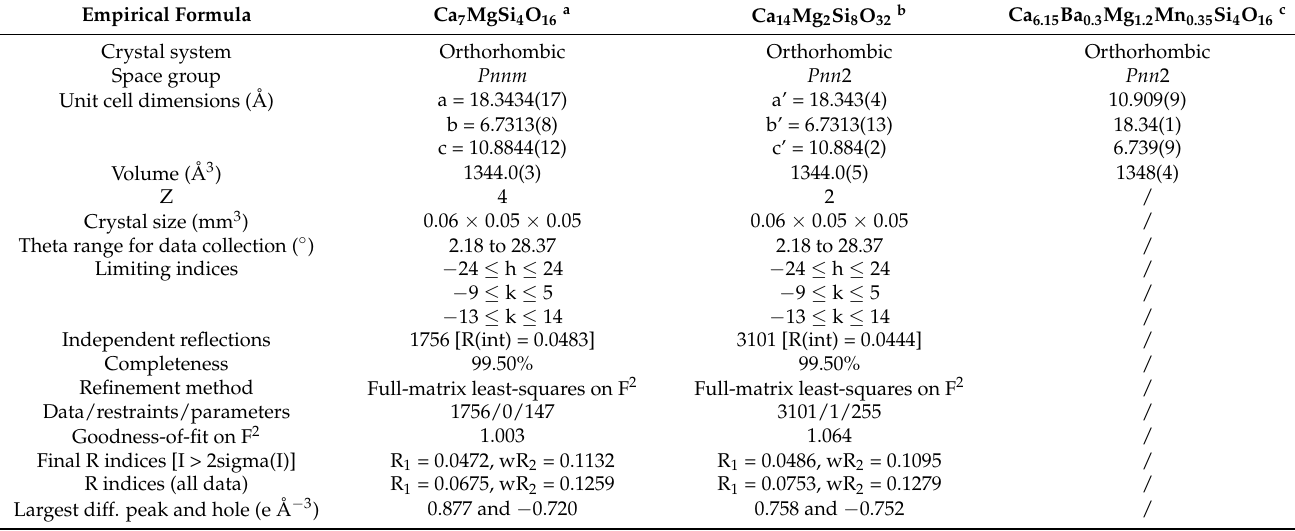
Table 1. Crystal data for bredigite structure and bredigite-like structure.